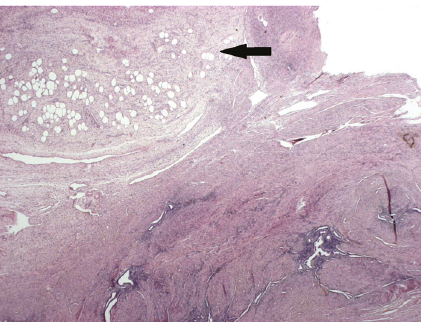
Figure 2: Lesion at low power-view with smooth muscle, glands, and adipocytes (one arrow) components. Lesion with adipocytic (center of the lesion, arrow) and glandular components